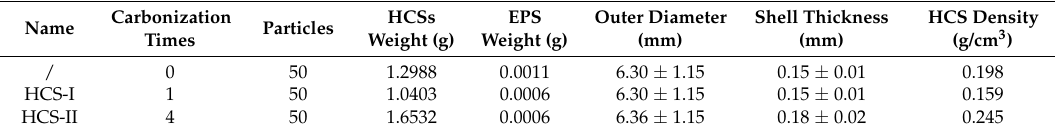
Table 1. Parameters of HCSs before and after carbonization: Size and density.